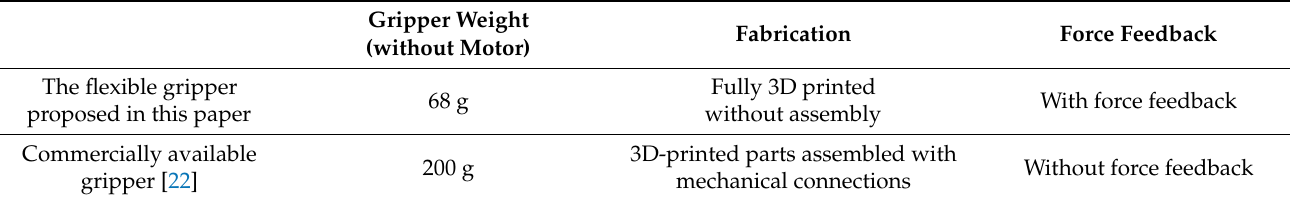
Table 1. Comparison between the proposed flexible gripper and a commercially available gripper based on the Fin Ray